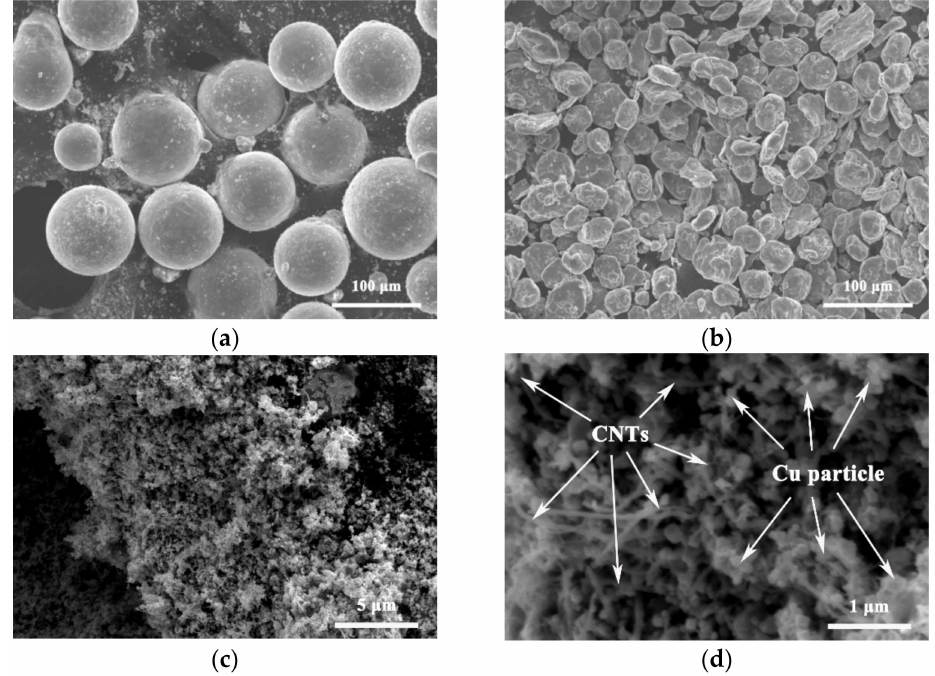
Figure 2. SEM images of AZ61 powder: ( a ) as-received and ( b ) after refinement of ball milling. SEM diagrams of copper-coated CNTs with ( c ) low magnification and ( d ) high